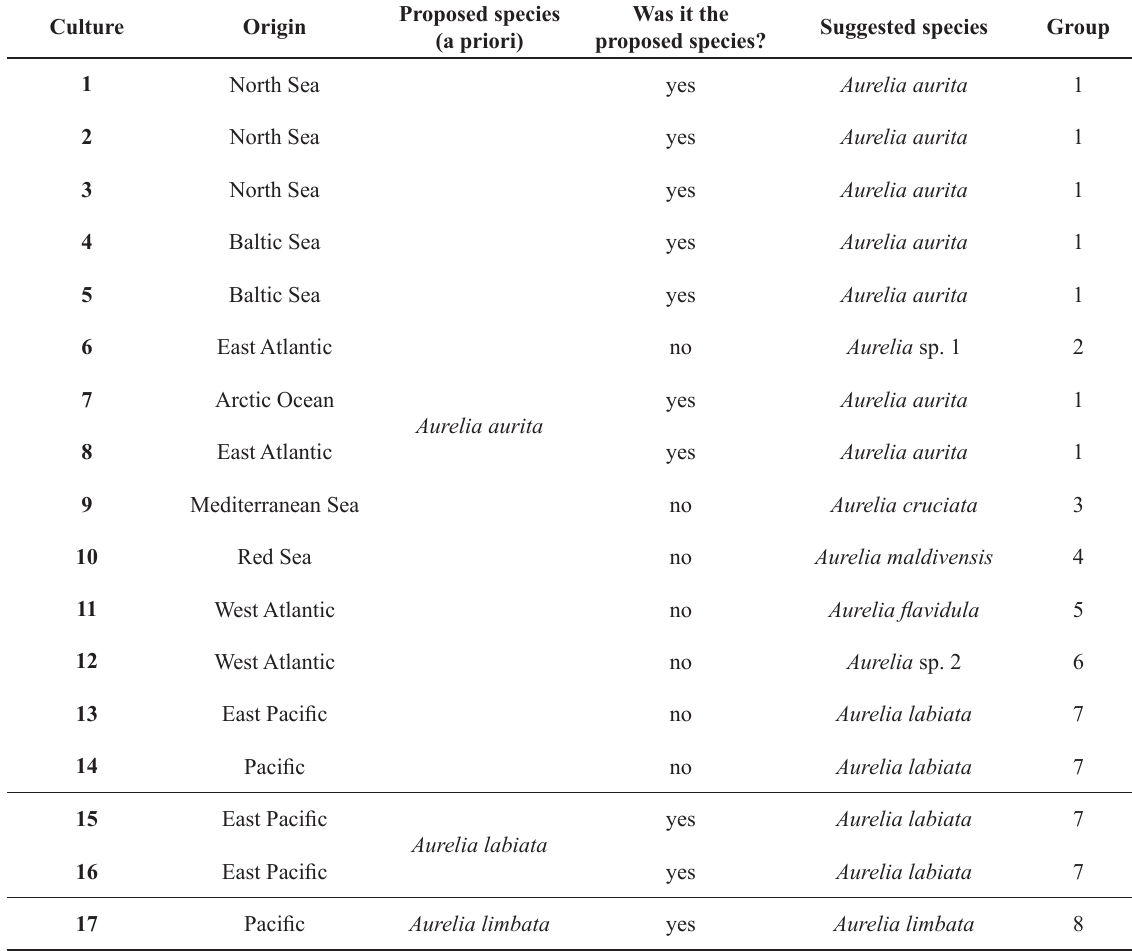
Table 6. Classification of the different populations (cultures 1–17) into eight different groups/species based on our results (morphological and statistical: Linear Discriminant Analysis [LDA]) under consideration of the literature (genetic and distributional